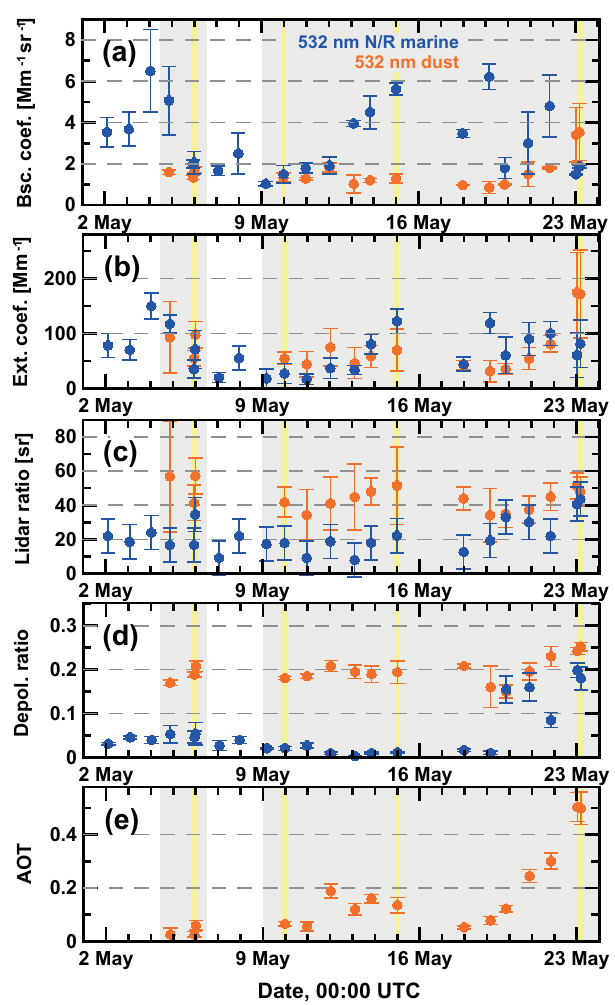
Figure 6. Layer mean values of (a) 532nm particle backscatter co- efficient, (b) extinction coefficient, (c) lidar ratio, and (d) linear de- polarization ratio observed with lidar on 20 nights in May 2013. Values for the SAL are given in red. The blue circles show the val- ues for pure marine conditions within the MAL (1–19 May) and for mixtures of dust and marine particles in the lowest 900m (19 May evening to 23 May morning). The 30–120min averages are pre- sented. Cases 1–4 are indicated as vertical yellow lines. The SAL AOT at 532nm is given in panel (e) . Error bars (1 standard devi- ation) indicate the retrieval uncertainty and atmospheric variability within the analyzed layers. The two periods with dust are shown as gray